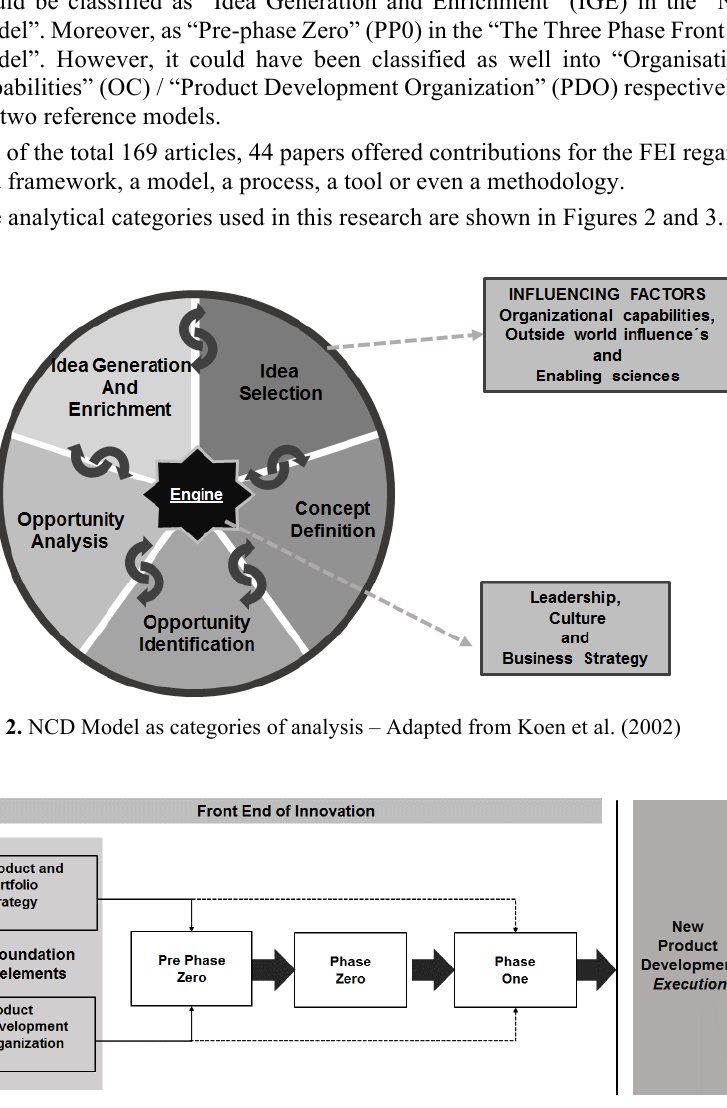
Fig. 3. Three Phase Model of the Front End of Innovation as categories of analysis – Adapted from Khurana and Rosenthal